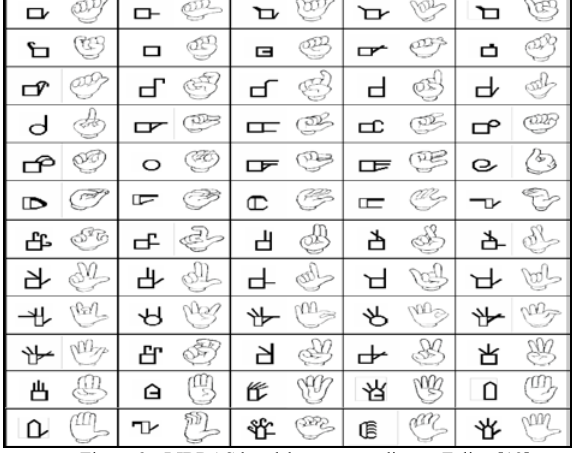
Figure 2 - LIBRAS handshapes according to Felipe [12] According to Brito and Langevin [7], palm orientation refers to the direction of palm during the sign that